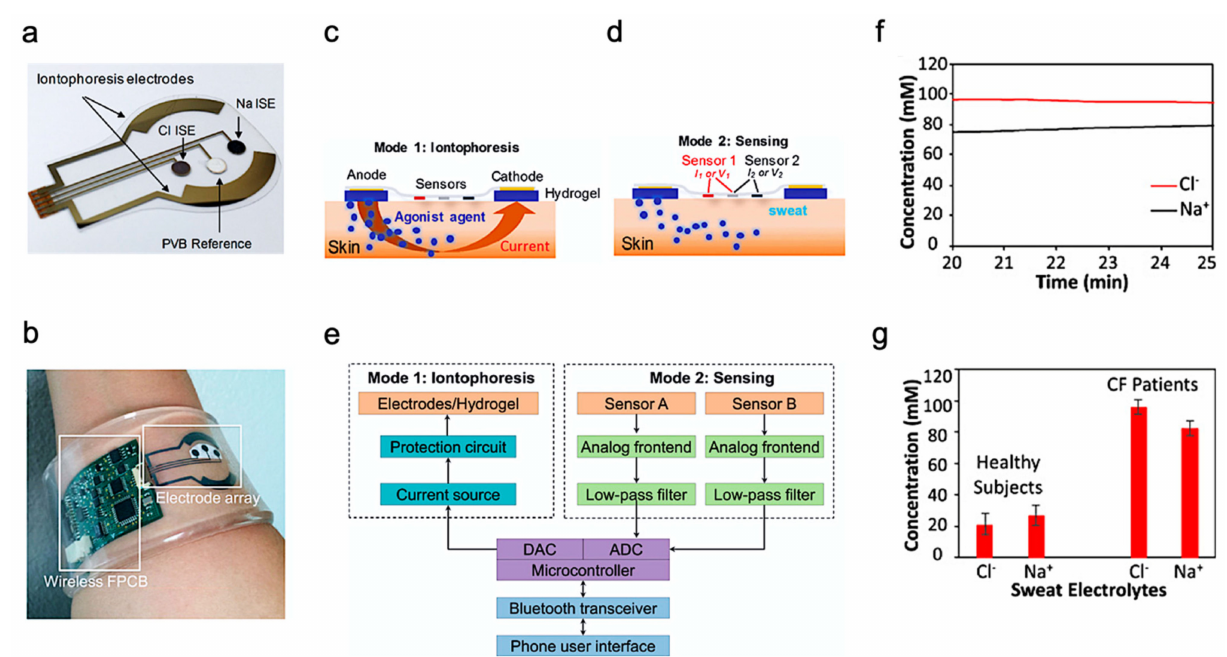
Figure 4. Overview of the developed CF monitoring device. ( a ) Electrodes used for iontophoresis and sensing. ( b ) Flexible wearable device on user’s wrist. ( c , d ) Description of the working modes of system ( c ) mode 1: Iontophoresis ( d ) mode 2: Sensing. ( e ) Block-level diagram of the developed system. ( f ) Real-time on-body measurement of sweat sodium ion and chloride ion levels of a CF patient after iontophoresis-based sweat stimulation. ( g ) Comparison of sweat electrolyte levels between six healthy subjects and three CF patients. Reproduced with permission from ref. [93], Copyright 2017, National Academy of Sciences